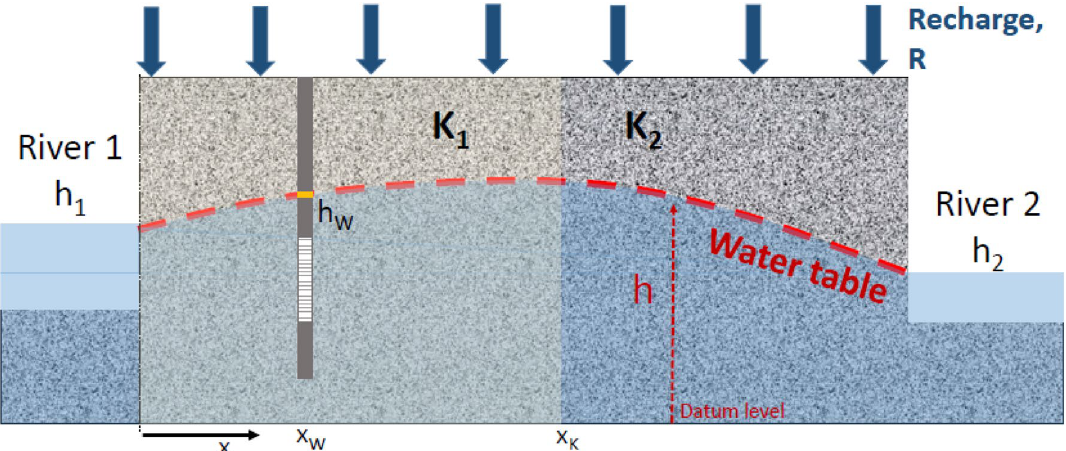
Fig. 1 Schematic of conceptual problem: Water table position for a phreatic aquifer located between two rivers that are connected to the groundwater system, so that they act as prescribed piezometric head boundary